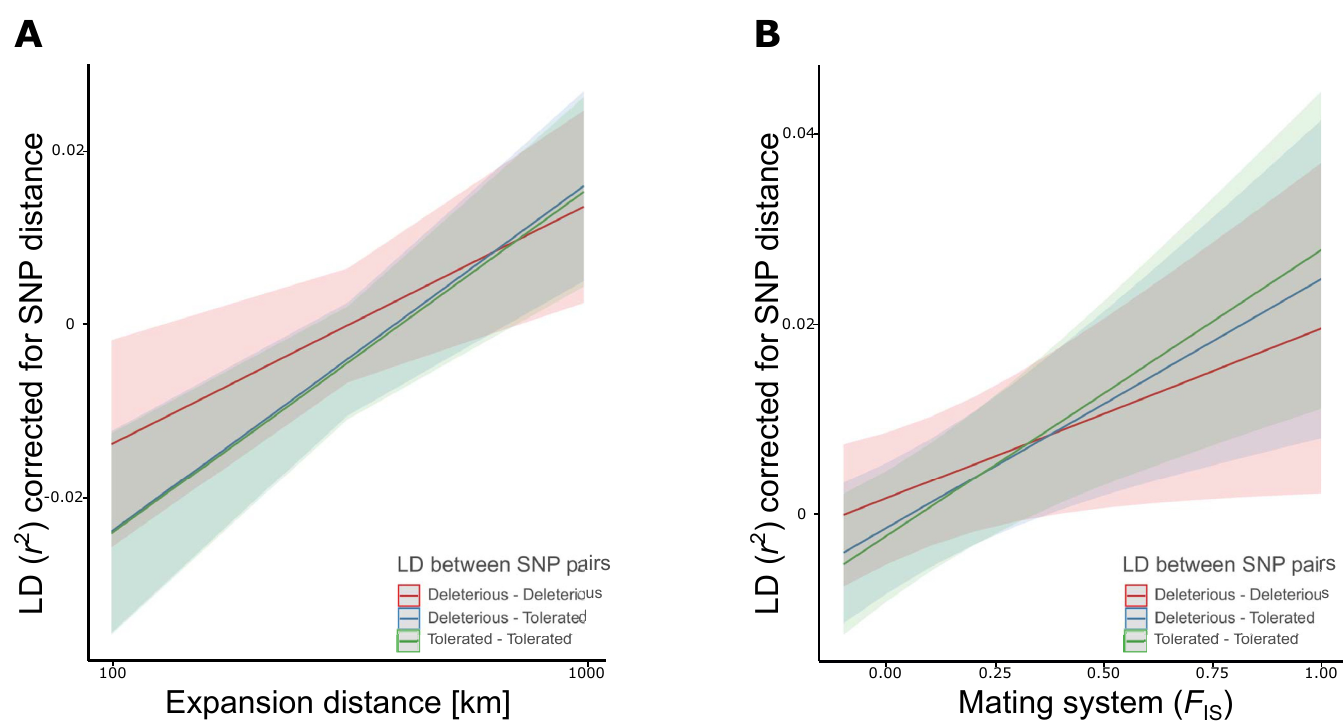
Fig 2. Marginal effects for the interactions of LD ( r 2 ) estimated from pool-seq between variants that were identified by SIFT to be both deleterious, deleterious and tolerated, or both tolerated, and expansion distance (km, log-scale) (A) and mating system ( F IS ) (B). Regression lines and their 95% confidence intervals were estimated from a linear mixed-effects model (see Table